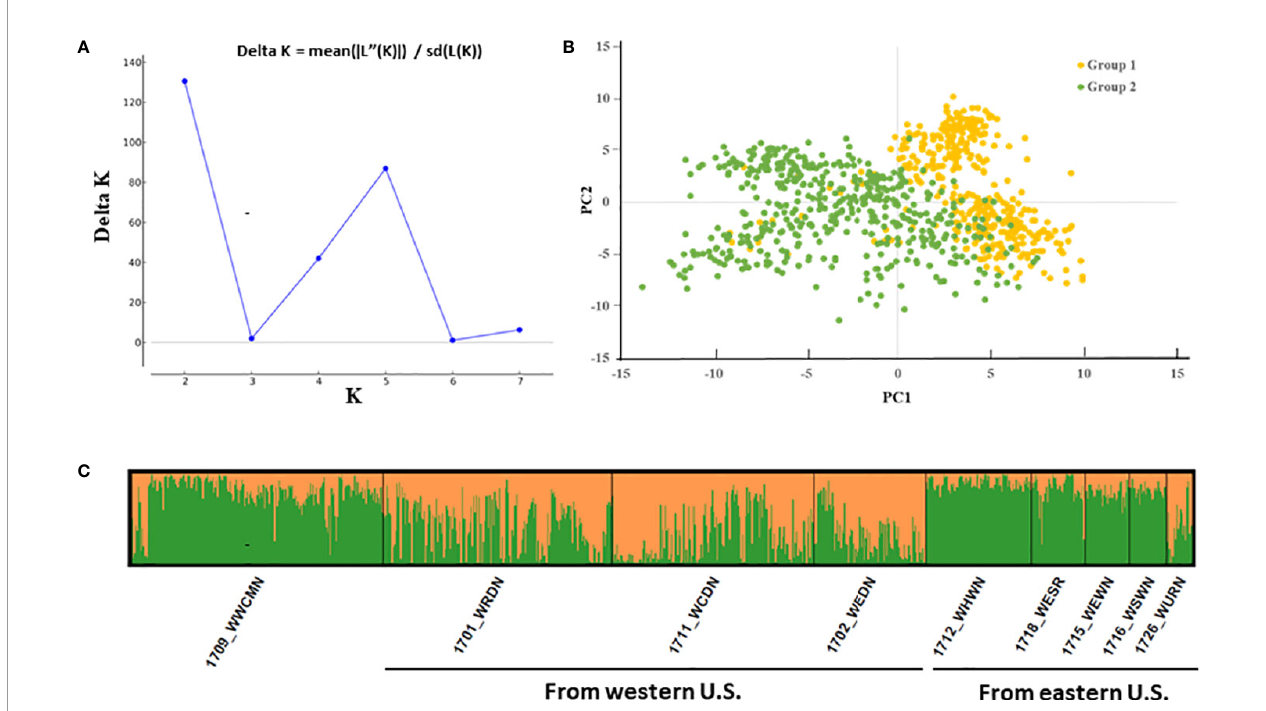
FIGURE 2 | Model-based population structure of the 857 winter wheat accessions combined with markers. (A) The result obtained from Structure Harvester analysis (k = 2). (B) The STRUCTURE analysis showed two hypothetical subpopulations represented by different colors. (C) First two components (PC1 and PC2) of a principal component